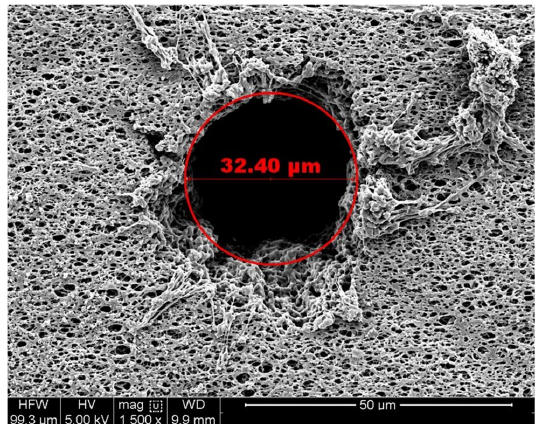
Figure 3. SEM image of a nominal 30 µm diameter laser hole in a SD-type membrane.